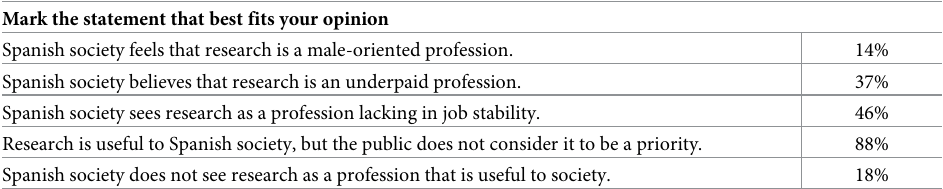
Table 7. Scientists’ views of the public perception of issues related to scientists. Mark the statement that best fits your